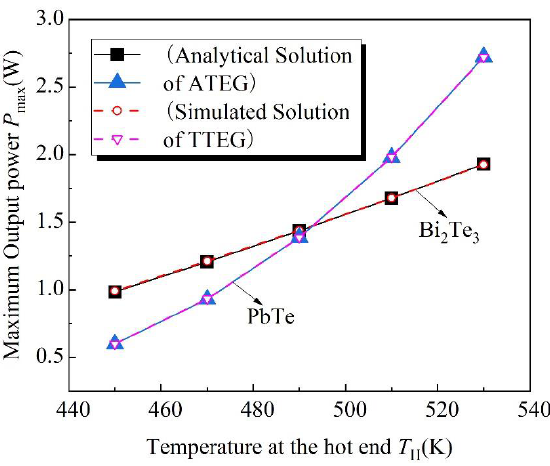
Figure 9. Maximum output power versus high temperature of different TEM.